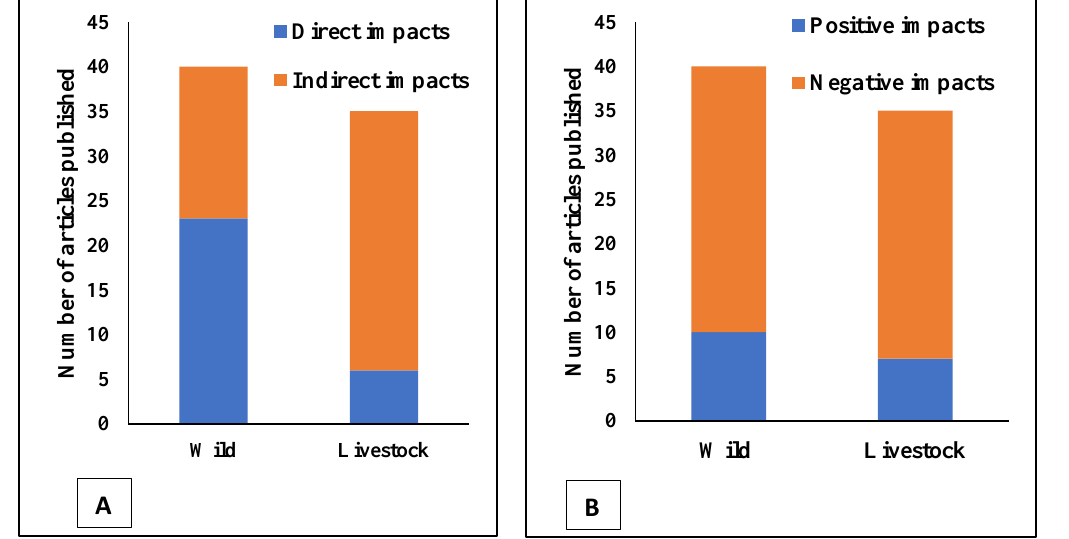
Figure 3. Different types of impacts ( A : direct and indirect or B : positive and negative, respectively) on reptiles by wild and domestic ungulates based on the reported 75 interactions between 1973 and 2021.